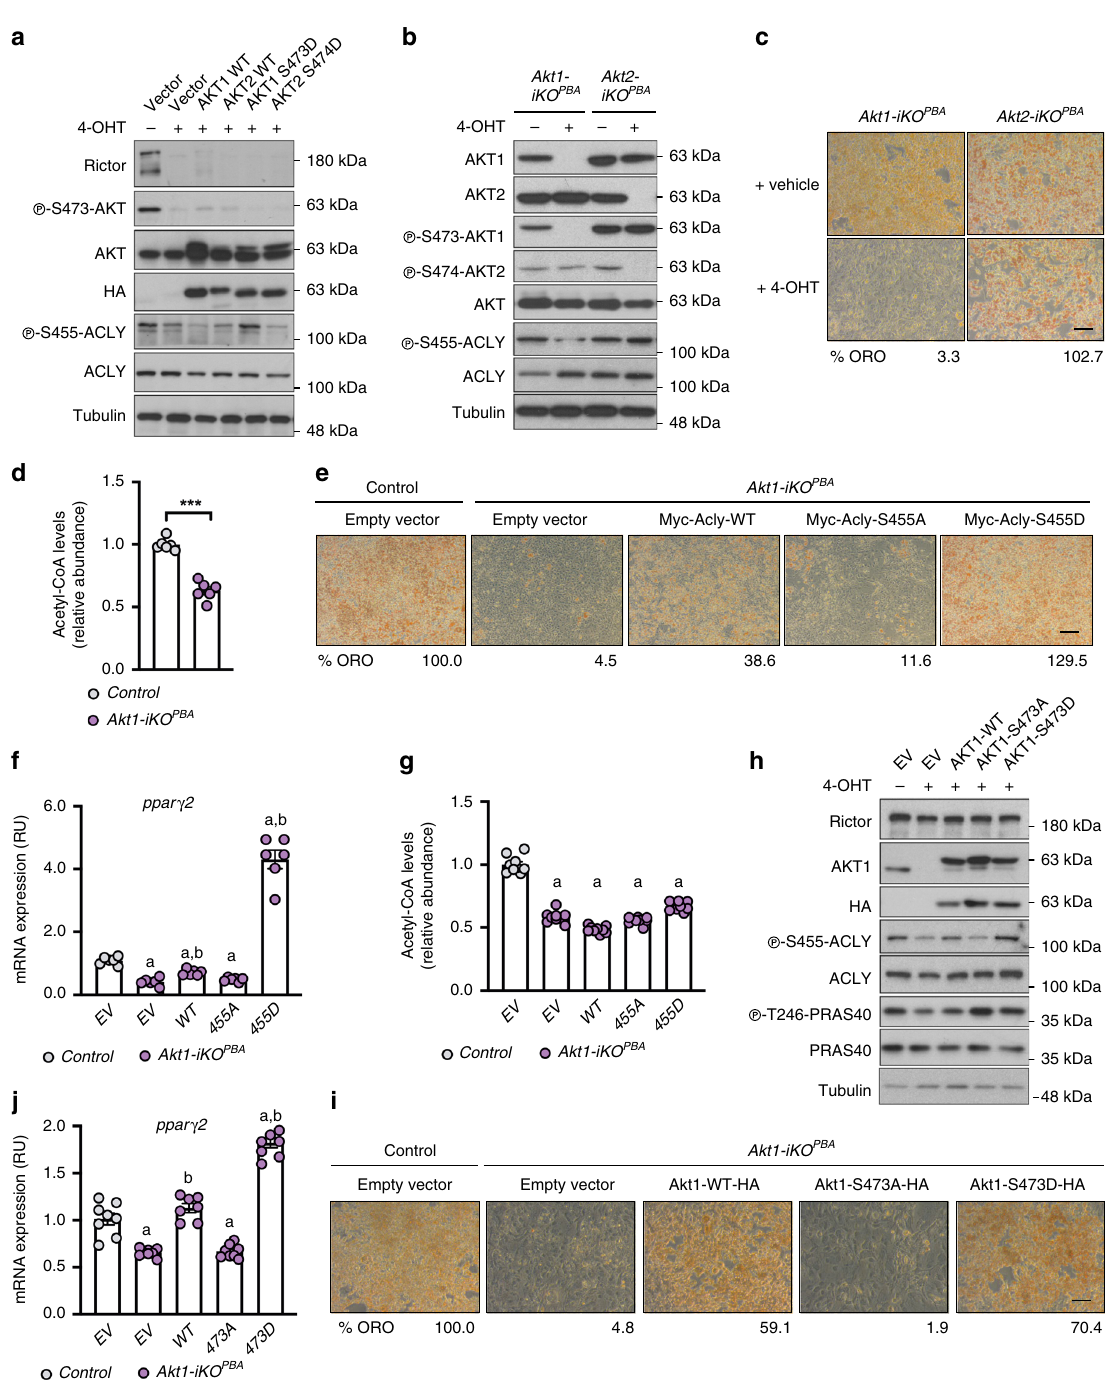
Fig. 4 AKT1 HM phosphorylation is necessary for ACLY stimulation and differentiation, while ACLY-S455D is suf fi cient to rescue acetyl-CoA levels and differentiation upon Rictor loss. a Rictor-iKO PBAs cells were stably transfected with the indicated HA-tagged AKT constructs, which were tested for their ability to rescue ACLY-S455 phosphorylation by western blot. b , c Western blot ( b ) and ORO ( c ) of Akt1-iKO PBAs and Akt2-iKO PBAs cells. Scale bar represents 50 μ m. d Direct acetyl-CoA measurements of Akt1-iKO PBAs cells ( n = 6 per group). e , f Representative differentiation rescue experiments showing ORO staining ( e ) and ppar γ expression ( n = 6 per group) ( f ) in Akt1-iKO cells stably expressing empty (EV), Myc-ACLY-WT, Myc-ACLY-S455A, or Myc-ACLY-455D constructs. Scale bar represents 50 μ m. g Direct acetyl-CoA measurements of Akt1-iKO PBA cells ( n = 9) stably transfected with the indicated Myc-tagged ACLY constructs. h – j Western blot ( h ), ppar γ expression ( n = 7 – 8 per group) ( i ), and ORO staining ( j ) of Akt1-iKO PBA stably expressing empty (EV), HA-AKT1-WT, HA-AKT1-S473A, or HA-AKT1-473D constructs. Scale bar represents 50 μ m. Bar graphs represent mean ± SEM. *** p < 0.001, a represents *** p < 0.001 vs control (EV), and b represents *** p < 0.001 vs Akt1-iKO PBA (EV). Statistical signi fi cance was calculated by using two-tailed unpaired Student ’ s t test ( d ) or two-way ANOVA with Sidak ’ s test multiple comparisons ( f , g , i